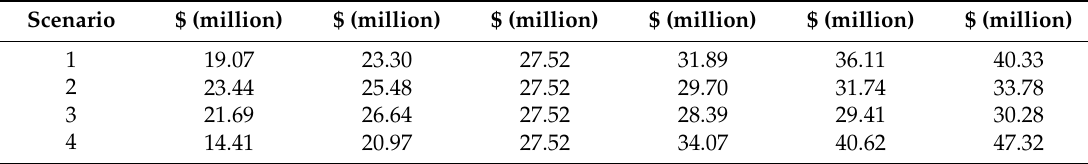
Table 9. Costs of four LID